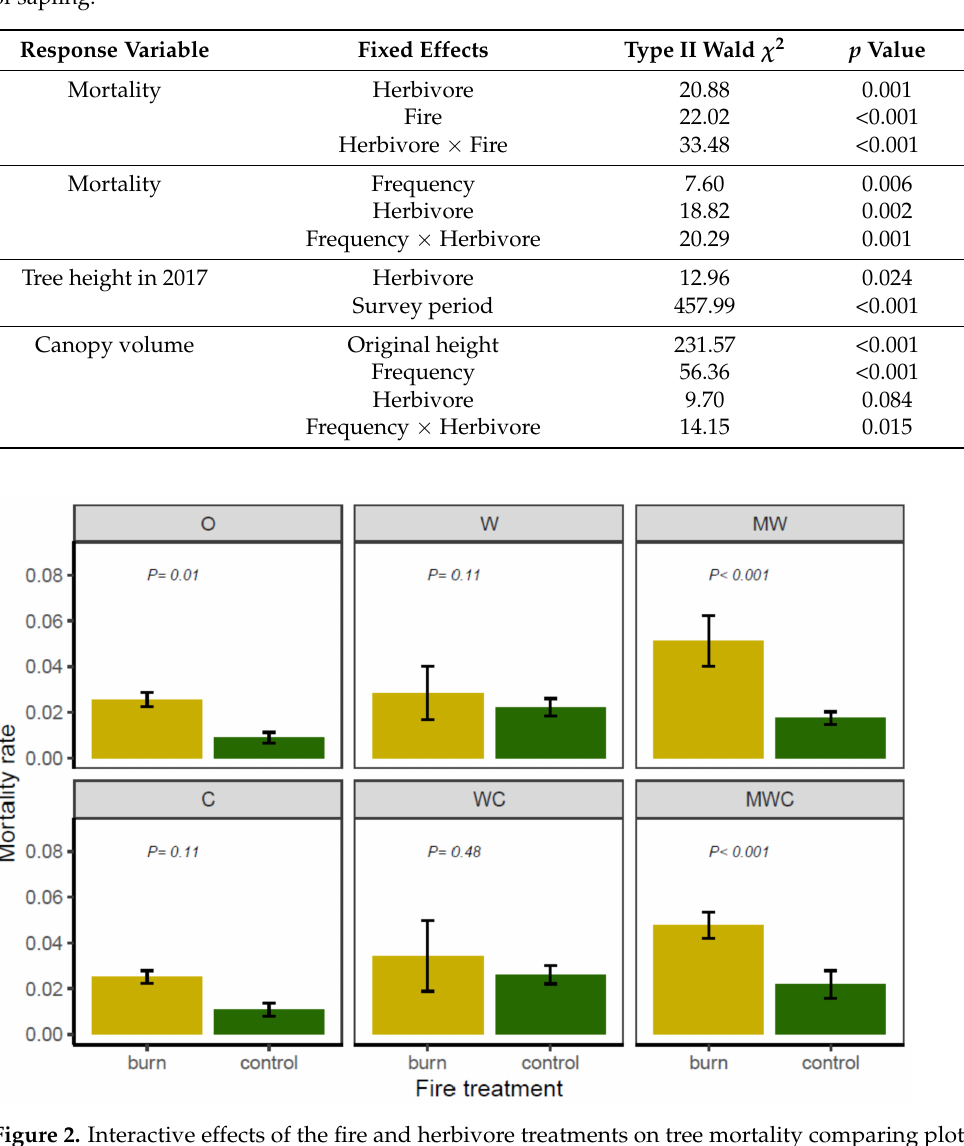
Figure 2. Interactive effects of the fire and herbivore treatments on tree mortality comparing plots burned for the first time in 2013 and in 2018. p values on top of the bars are obtained from all pairwise caparisons using emmeans in the R package emmeans